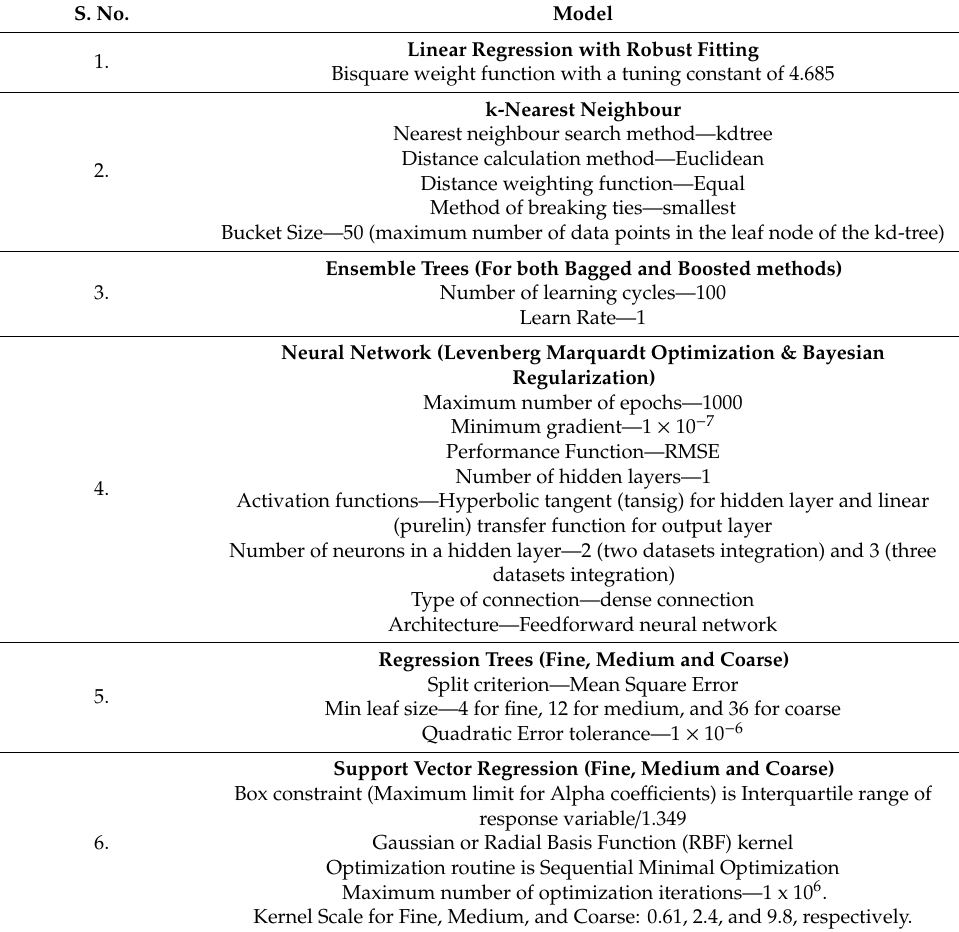
Table 1. Hyperparameter values for all the 16 machine learning algorithms used in the study. S. No. Model